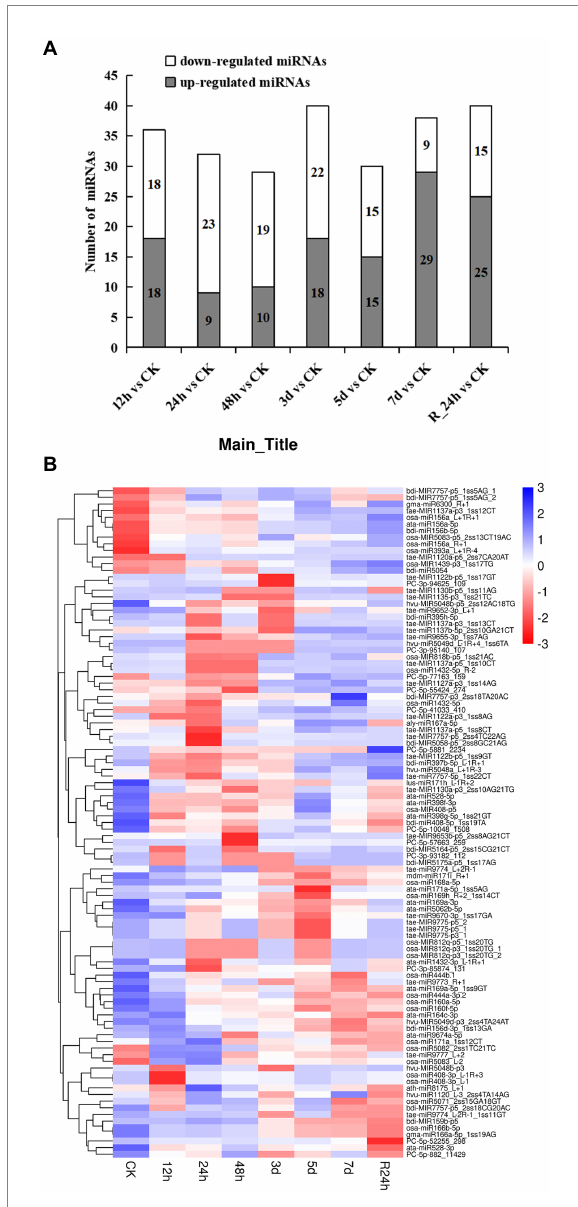
FIGURE 3 Differentially expressed miRNAs under drought stress. (A) The number of differentially expressed miRNAs compared with the control. (B) Hierarchical clustering of differentially expressed miRNAs in eight different durations of drought treatment [CK (0 h), 12 h, 24 h, 12 h, 48 h, 3 days, 5 days, 7 days, and R24 h]. Red indicates a lower level of expression of the miRNAs, and blue indicates higher levels of expression of miRNAs. The names of the samples are shown at the bottom, and the name of the differentially expressed gene is shown on the right. The norm expression of miRNA was standardized using a Z-score. The absolute signal intensity ranges from − 3 to +3, and the corresponding color changes from red to